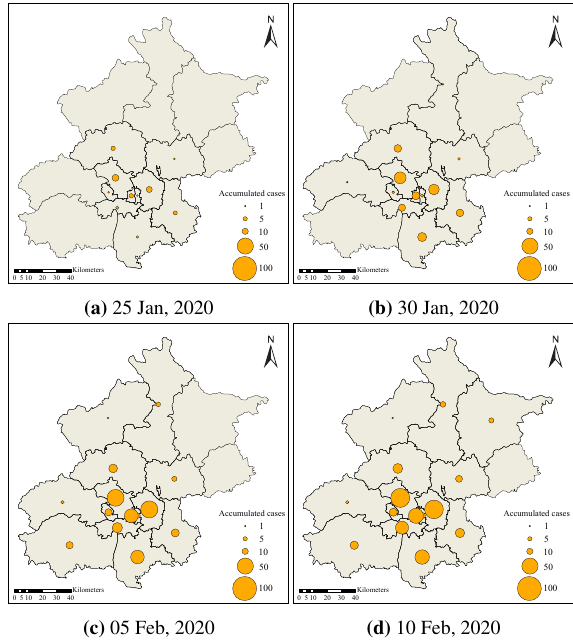
Figure 2. Snapshots of accumulated confirmed cases in